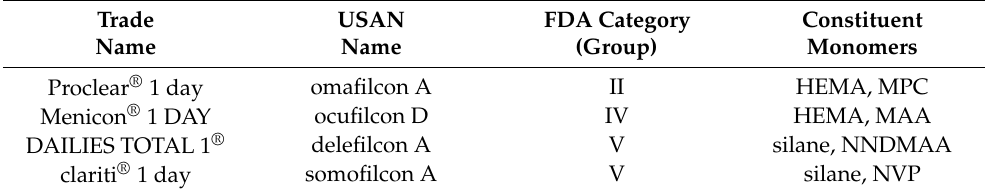
Table 1. SCLs used in the